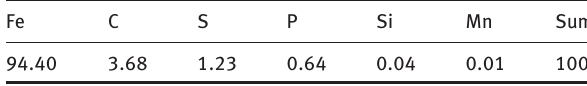
Table 1: Composition of the iron nugget (mass fraction, %) Fe C